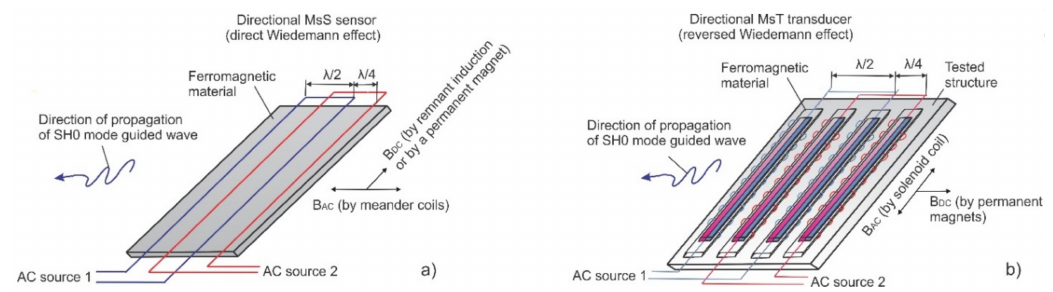
Figure 9. Directional transmission of guided waves: ( a ) utilizing two quarter-wavelength spaced meander coils (each coil has two conductors that are separated by one half of the wavelength); ( b ) utilizing two quarter-wavelength spaced MsT type transducers (each transducer in turn has two channels separated by one half of the wavelength and connected to reject the unwanted